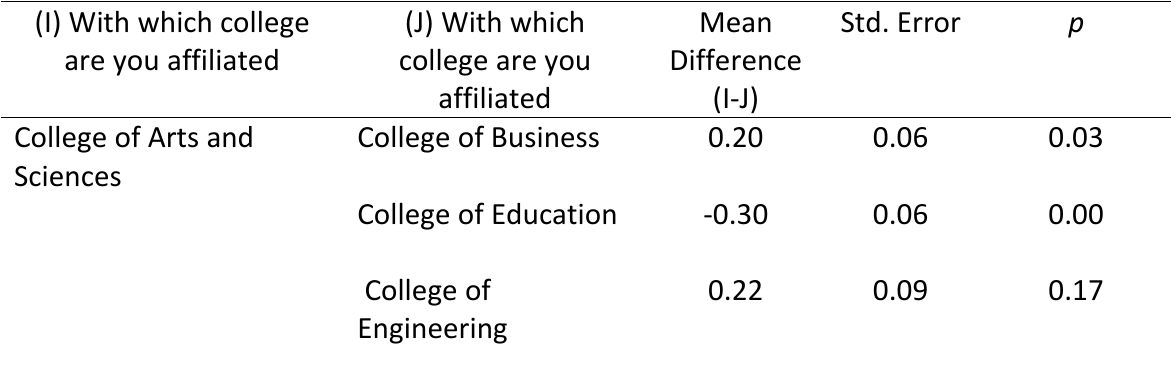
Post Hoc Multiple